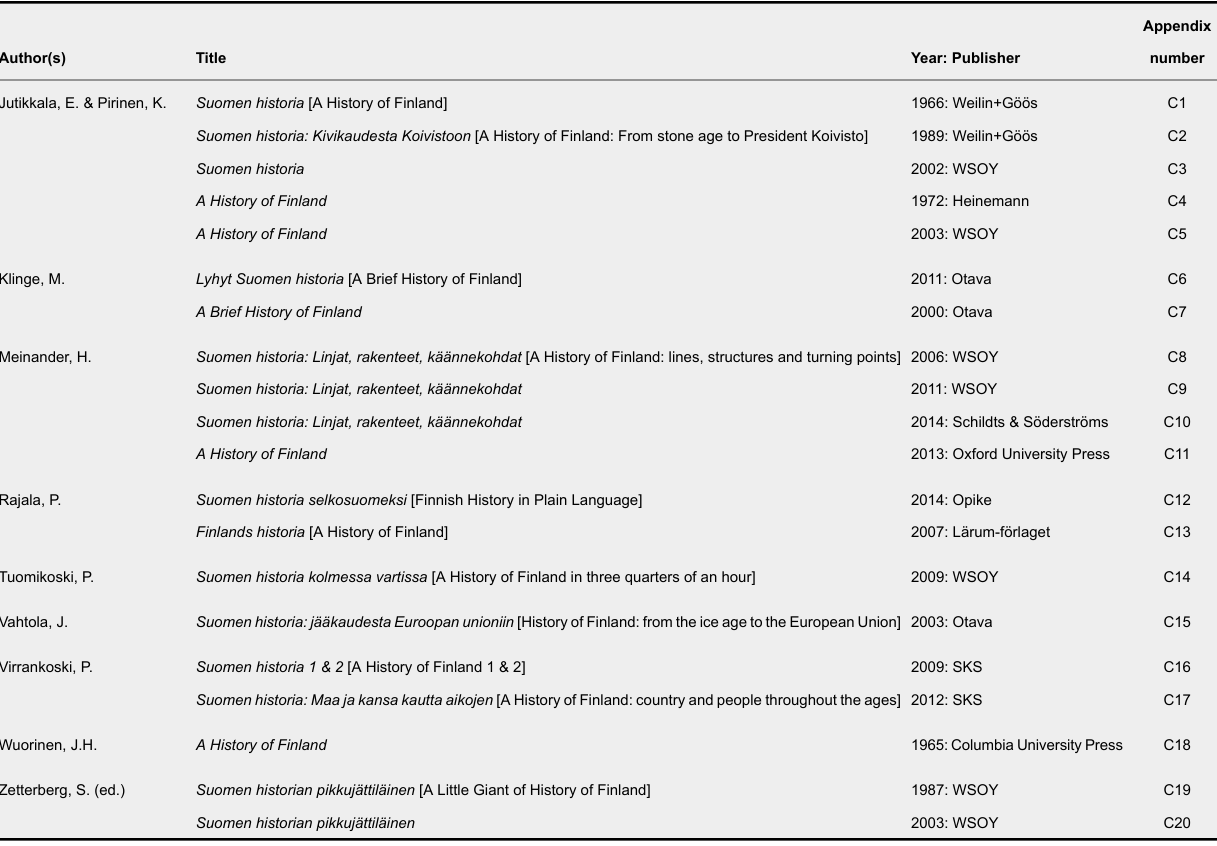
Authors, Titles, Publishers and Dates of the History Books